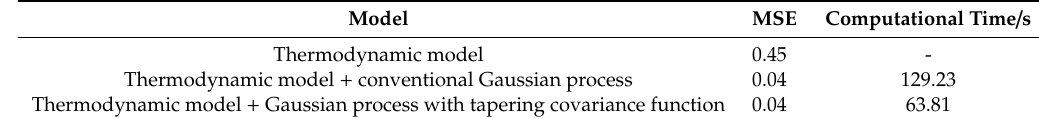
Table 4. Comparison of model performance using various Gaussian process